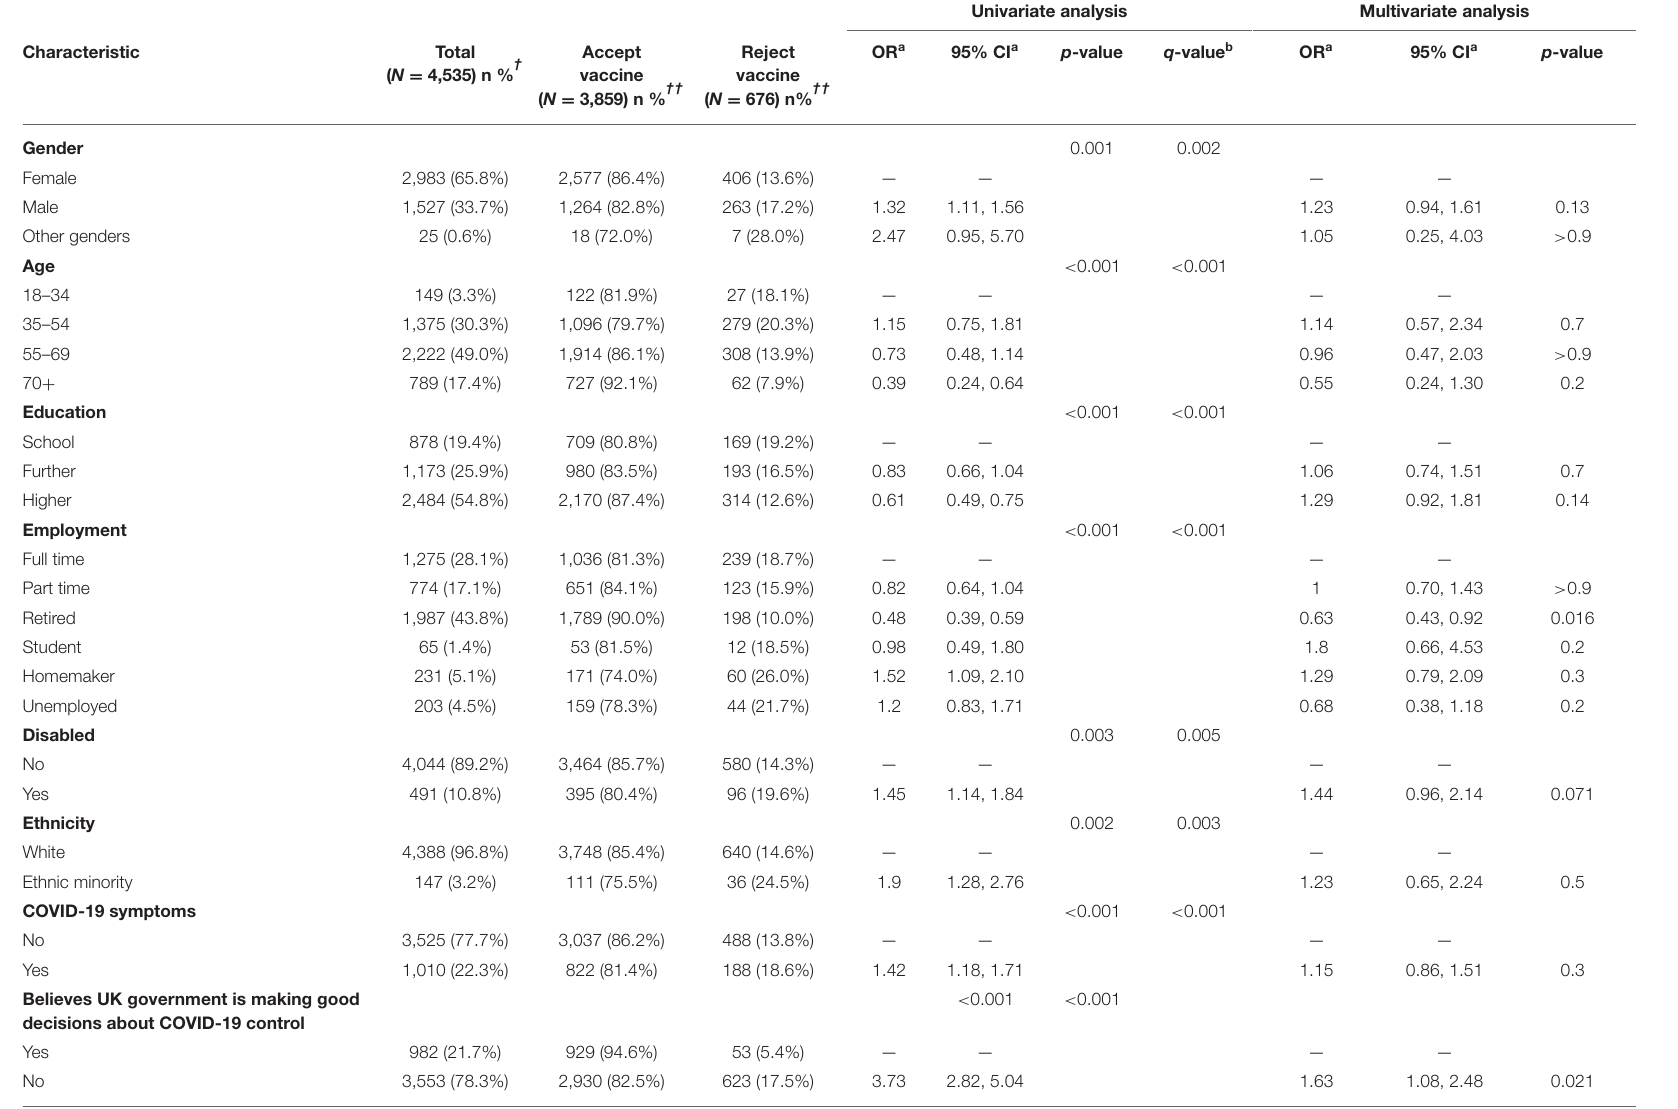
Univariate analysis Multivariate